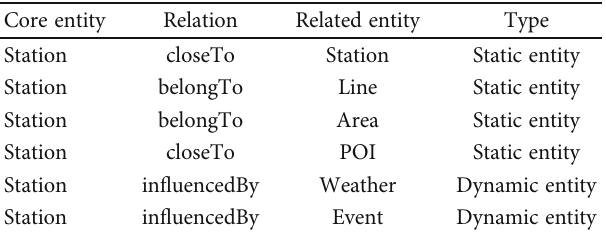
Table 3: Main entities and relation in the pretrained tra ffi c knowledge